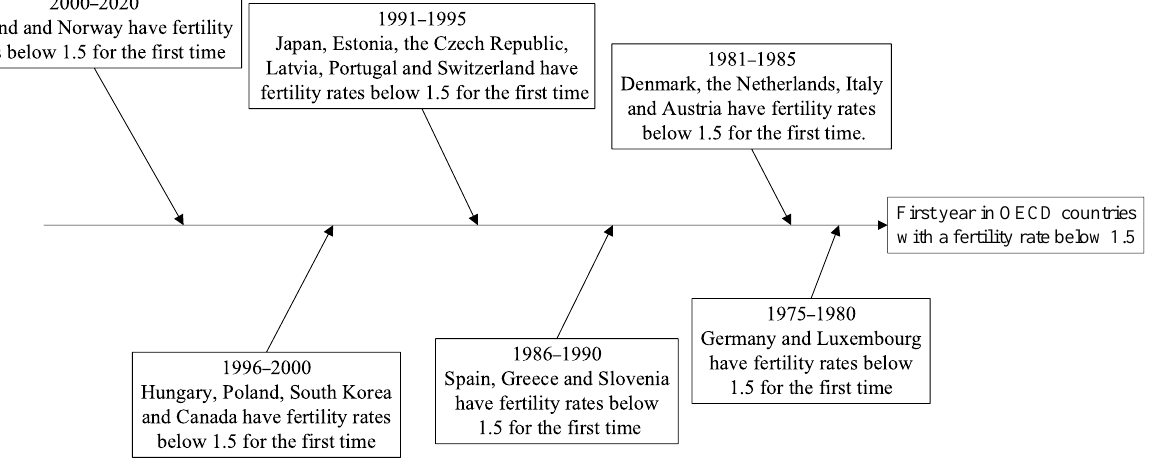
Figure 1. Countries in the OECD with fertility rates below 1.5 for the first time. Data source: OECD family database.